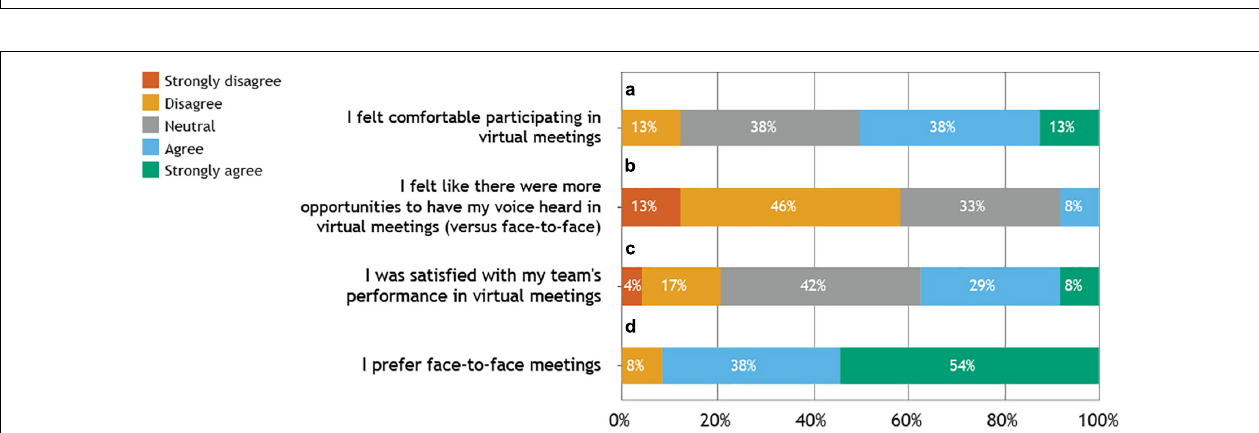
FIGURE 7 | Responses ( n = 24) to What is your level of agreement with the following personal statements?